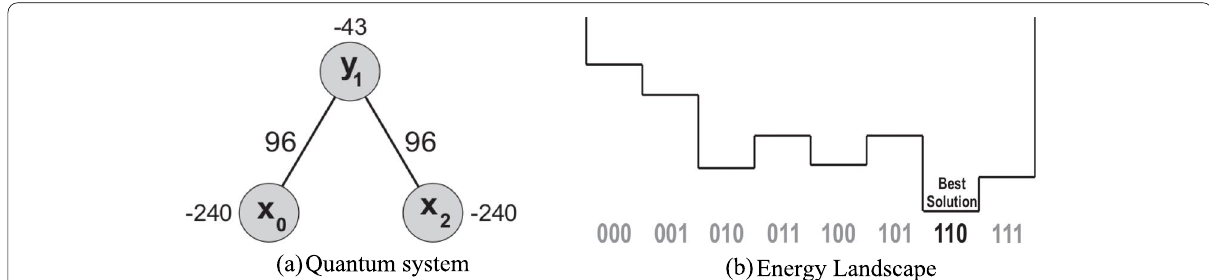
Fig. 3 Quantum system and energy landscape for the QUBO expression − 43 y 1 − 240 x 0 − 240 x 2 + 96 y 1 x 0 + 96 y 1 x 2